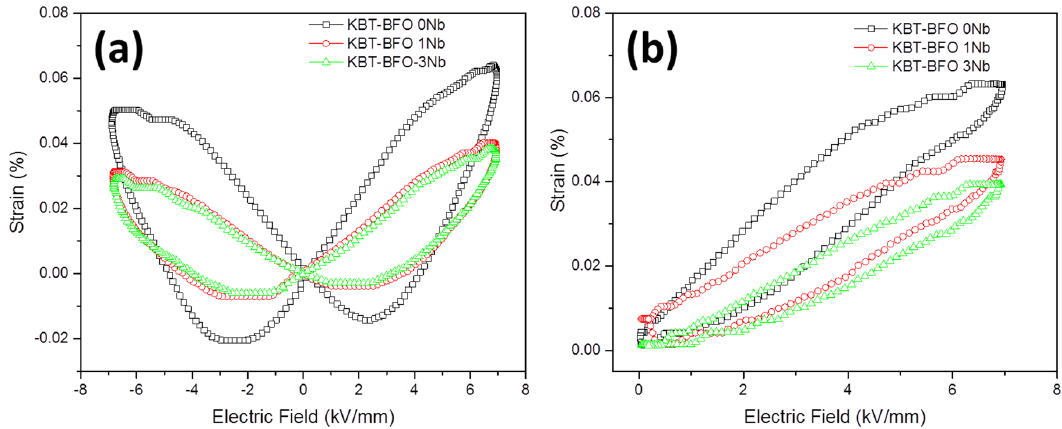
Figure 8. ( a ) Bipolar and ( b ) unipolar strain vs. electric field for 0.4(K 0.5 Bi 0.5 )Ti (1 − x ) Nb x O 3 ‐ 0.6BiFe (1 − x ) Nb x O 3 samples sintered at 1050 °C for 1